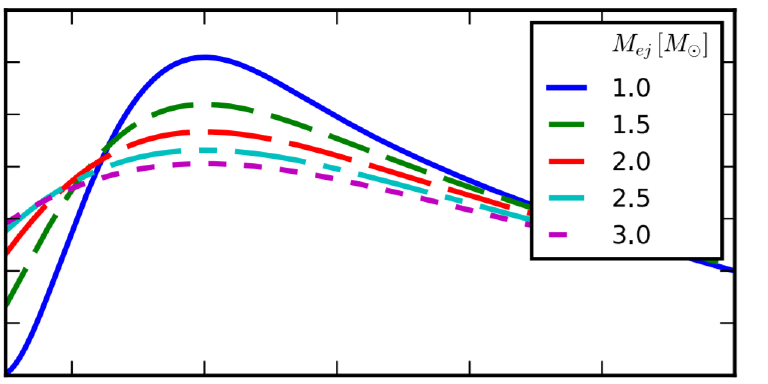
Figure 4. Type Ia light curves for different values of Chandrasekhar mass showing that the peak luminosity decreases as the Chandrasekhar mass increases and thus the Gravitational constant decreases. Adapted from: